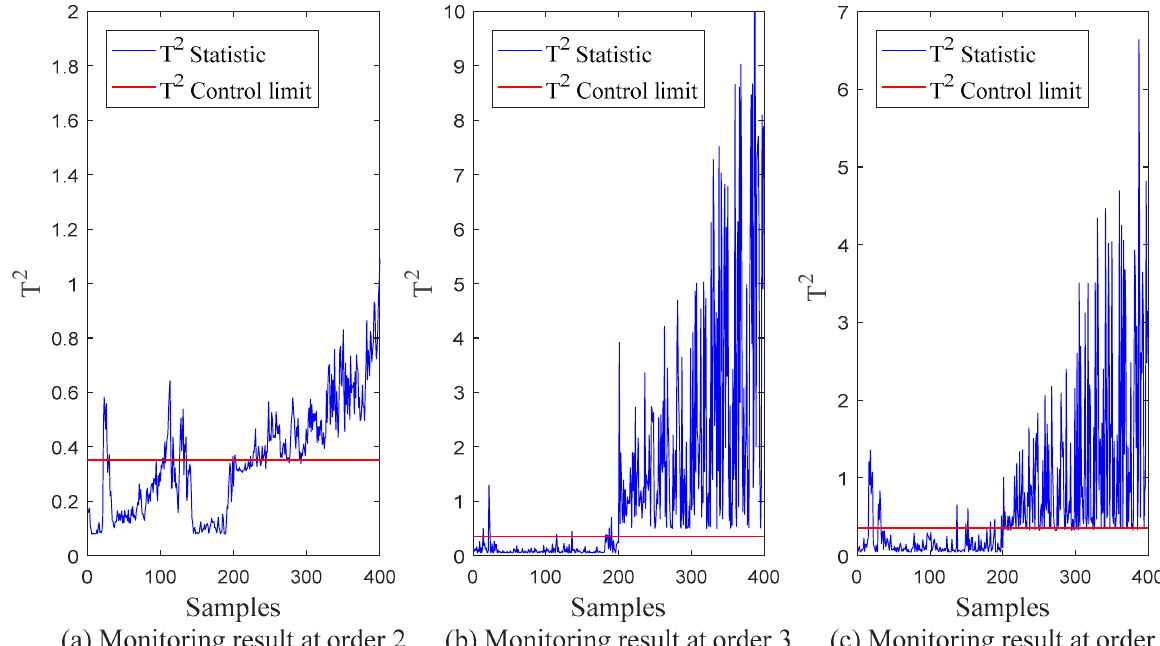
Figure 5. Monitoring performance under different time lag. ( a ) Monitoring result at order 2; ( b ) monitoring result at order 3; ( c ) monitoring result at order 4.